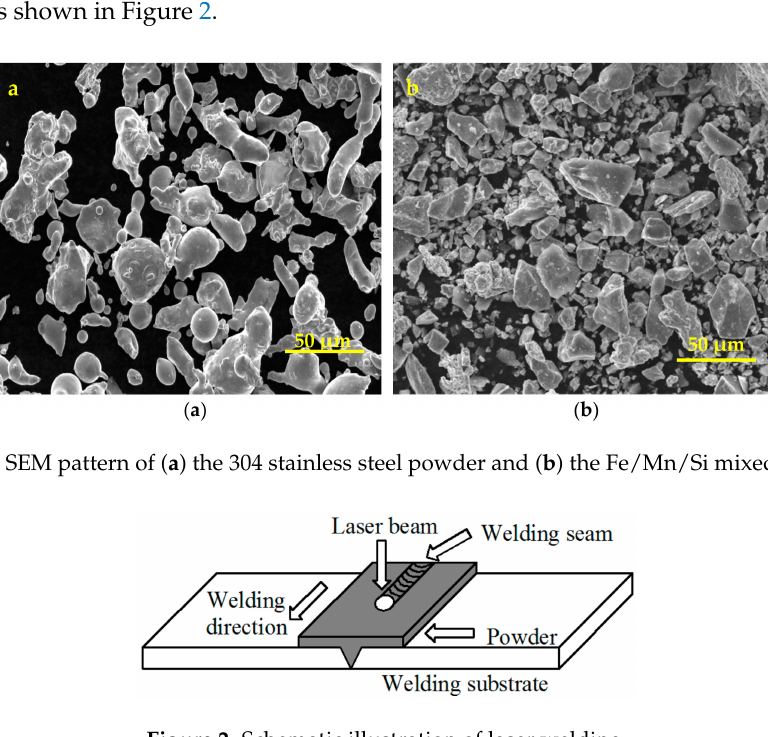
Figure 2. Schematic illustration of laser